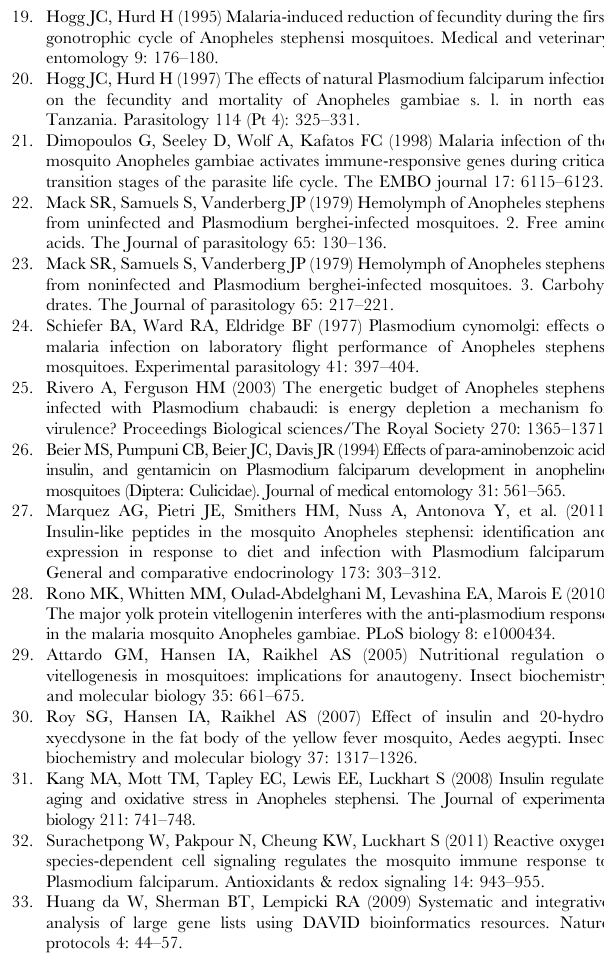
Figure S2 Evaluation of microarray results by qRT- PCR. Asterisks (*) indicate transcripts that are involved in carbohydrate catabolism (Table S3). AGAP009049 and AGAP005690 are up-regulated transcripts whereas AGAP006191 is a randomly picked transcript that is down-regulated (Table S1). Figure S3 Knocking down efficiency from experiments shown in Figure 5B. Expression level of indicated genes in P. berghei -infected A. gambiae from Figure 5B were determined by qRT-PCR compared to the expression level of A. gambiae actin gene. Each dot represents the relative expression level of indicated genes in one mosquito normalized to A. gambiae actin gene. Bars indicate mean values. Note that there was an enhanced expression of ILP5 at 8 days post injection in animals injected with pooled dsRNA for ILPs, probably due to compensation mechanism. Table S1 Differentially expressed transcripts with annotation data.